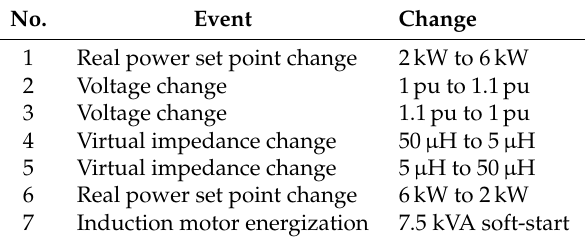
Table 3. Cases under consideration for the grid-connected